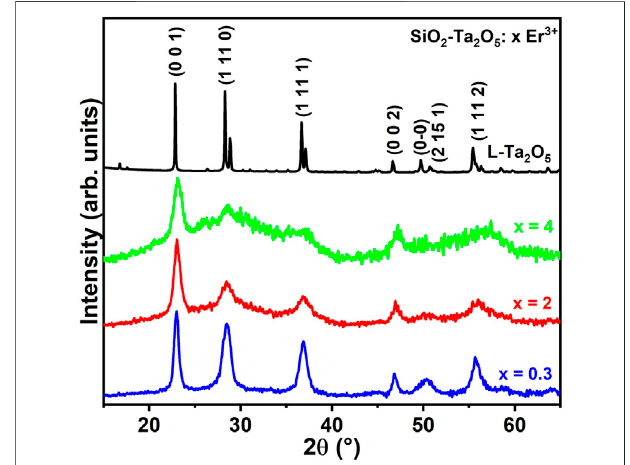
FIGURE2| PowderXRDpatternsof0.3,2.0,and4.0 mol%Er 3+ -doped